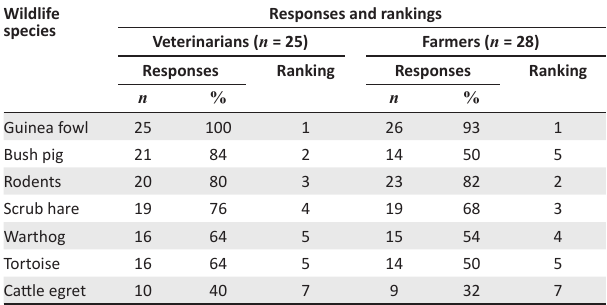
TABLE 6: Presence and rankings (1 most important to 7 least important) of intermediate hosts for heartwater in the areas